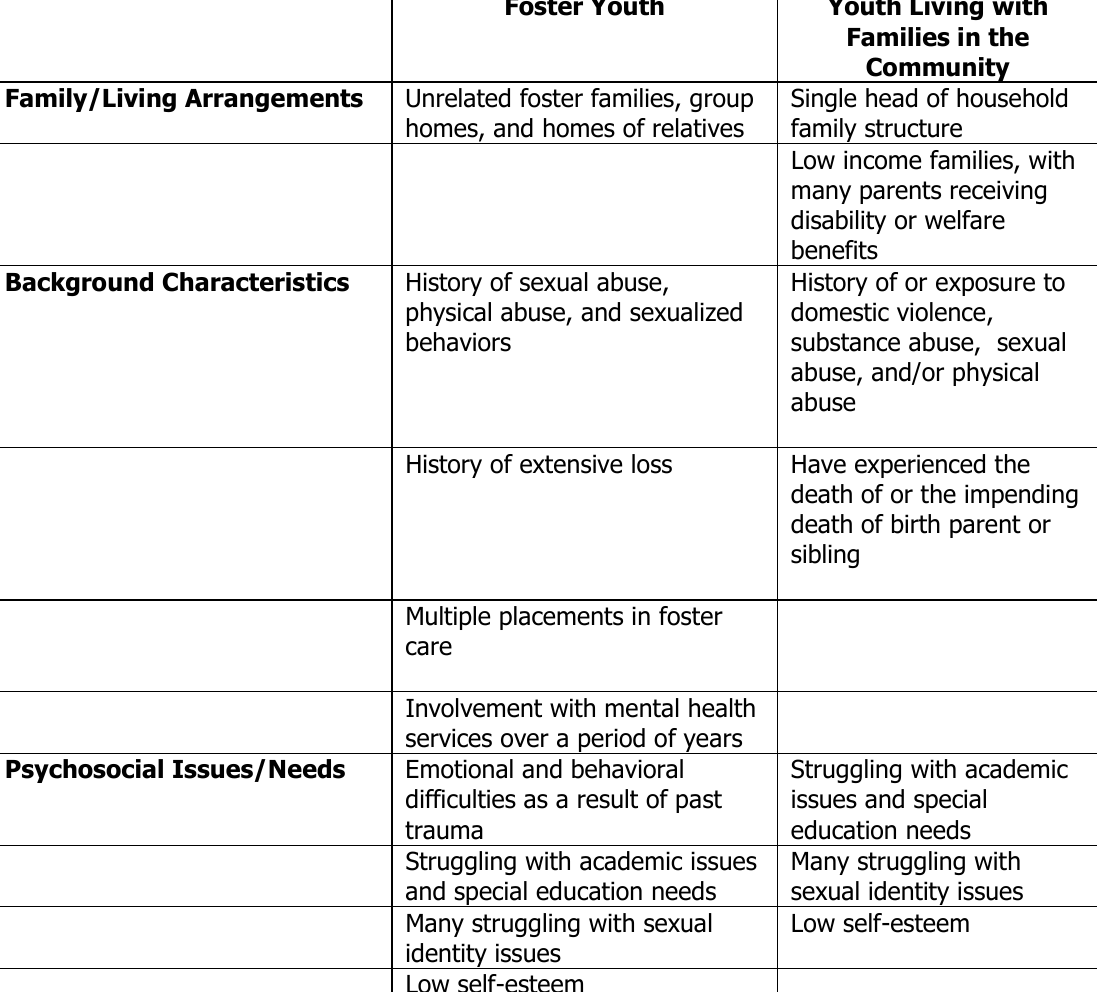
Characteristics of Youth Participants in the Performing Arts